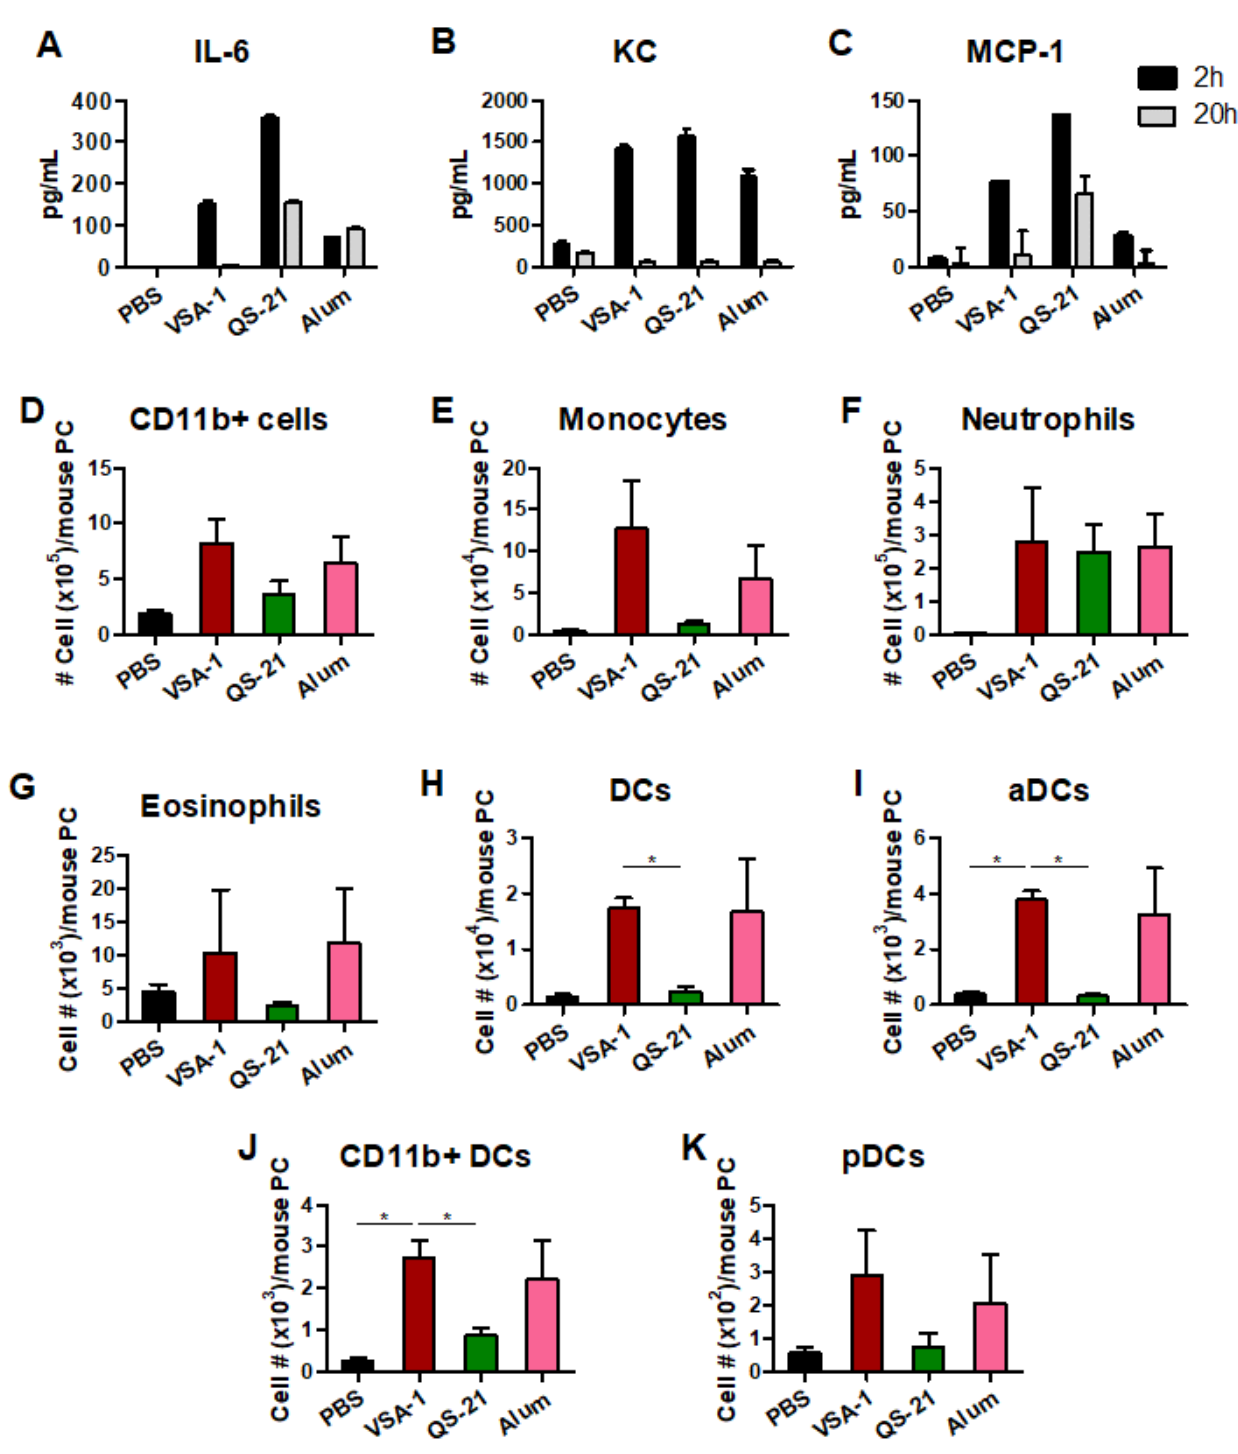
Figure 9. Acute innate immune induction of cytokines and chemokines in sera and innate cellular infiltrates in the peritoneal cavity (PC) after intraperitoneal injection of adjuvants. Naïve C57BL/6 mice ( n = 3 per group) were intraperitoneally injected with PBS, VSA-1 (50 µ g), QS-21 (10 µ g), or Alum (50 µ g). ( A – C ) Cytokine and chemokine ELISA levels in sera. ( D – K ) Cellular phenotypes in peritoneal exudates. Error bars indicate the mean ± SEM. *; p < 0.05 compared to the VSA-1 group. The phenotypes of innate cells infiltrated into the peritoneal cavity at 20 h after injection with adjuvants were determined by flow cytometry (Figure 9D–K). VSA-1